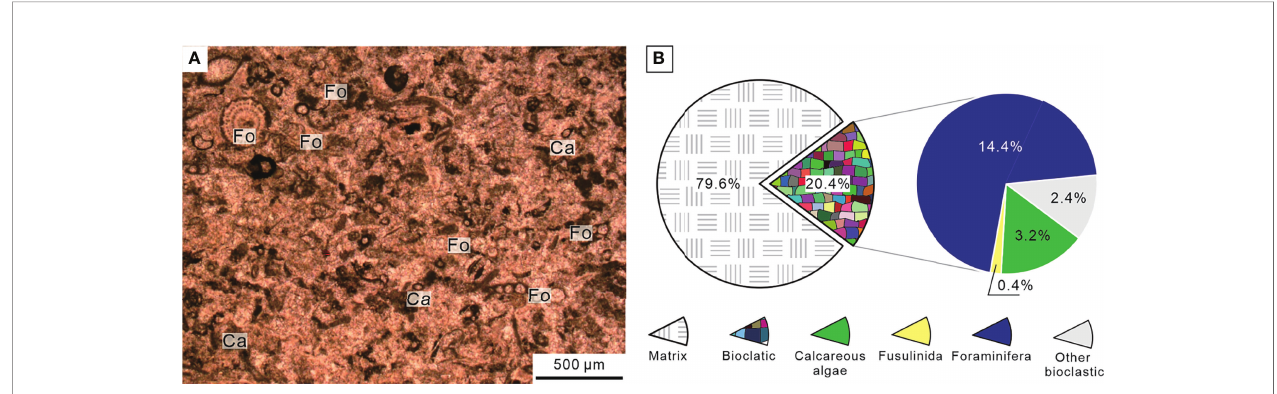
FIGURE 6 | Micropetrologic characters (A) and percentages of fossil assemblages (B) of bioclastic packstone from Bed 5 in the Chibi section before the PTME. Ca, Calcareous algae; Fo, Non-fusulinida foraminifera.